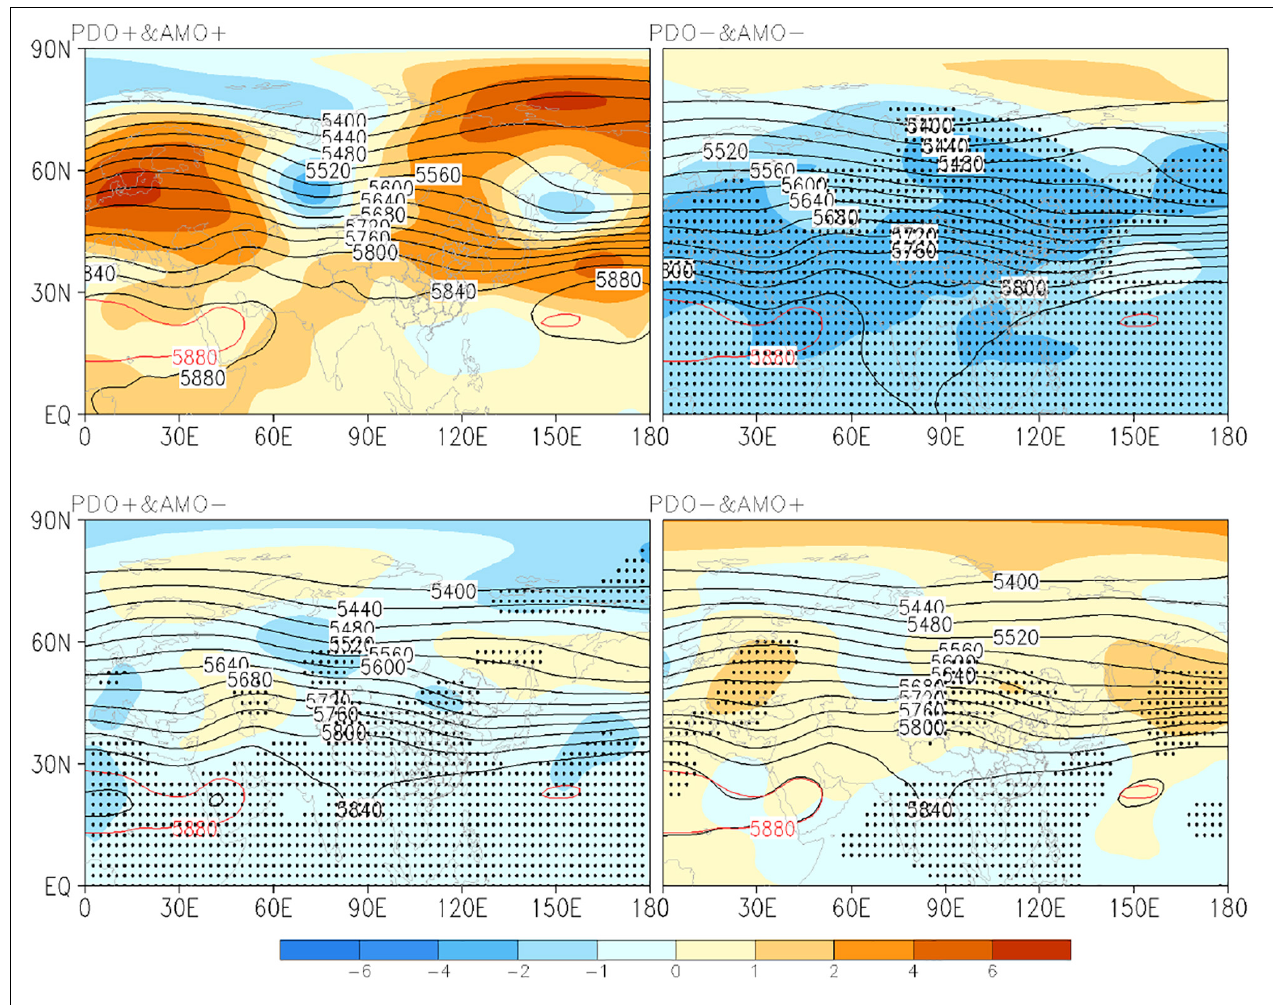
FIGURE 10 | The same as Figure 8 , but for the next years of La Niña